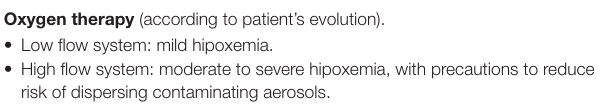
TABLE 1 | Key points in respiratory management of Covid-19 in Children (49, 77). Oxygen therapy (according to patient’s